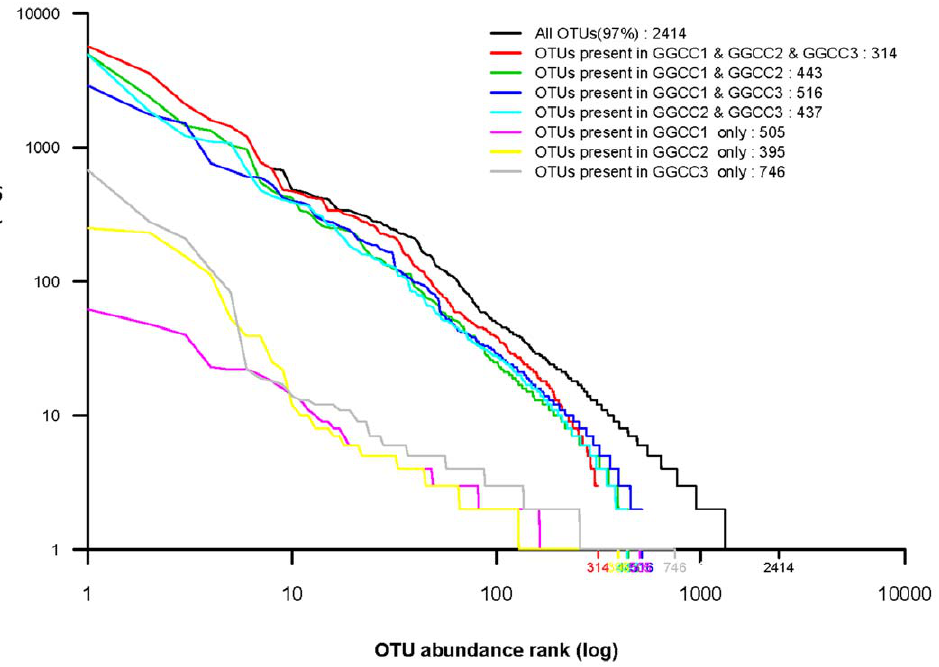
Figure 4. Rank abundance analysis of the different bacterial community groups. Rank abundance distribution curves showing the OTUs within each category of the Venn diagram in Fig. 3A ranked according to their abundance in the corresponding combined OTU sequence data set.